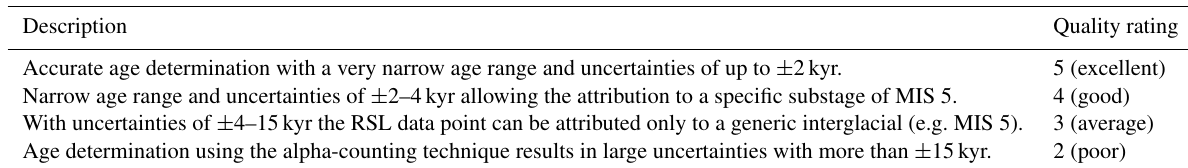
Table 8. Evaluation of the RSL data quality. Description Quality rating Final RSL uncertainty is between 1 and 2m. 4 (good) Final RSL uncertainty is between 2 and 3m. 3 (average) Final RSL uncertainty is higher than 3m. 2 (poor) Taxa determination only at the genus or family level with a large modern depth range. Final RSL uncertainty is very large, higher than 7m. No taxa determination. Final RSL uncertainty is very large, about 15m.